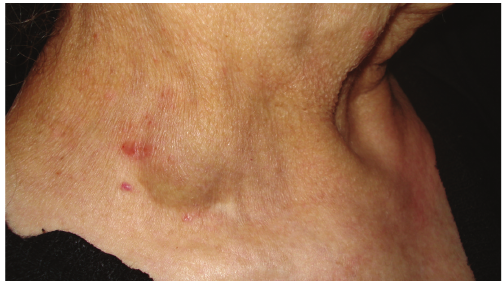
Figure 1: A 74-year-old woman presented with a lump at the right supraclavicular fossa which had been enlarging progressively over a period of a few months. The lesion corresponded to an aneurysm of the external jugular